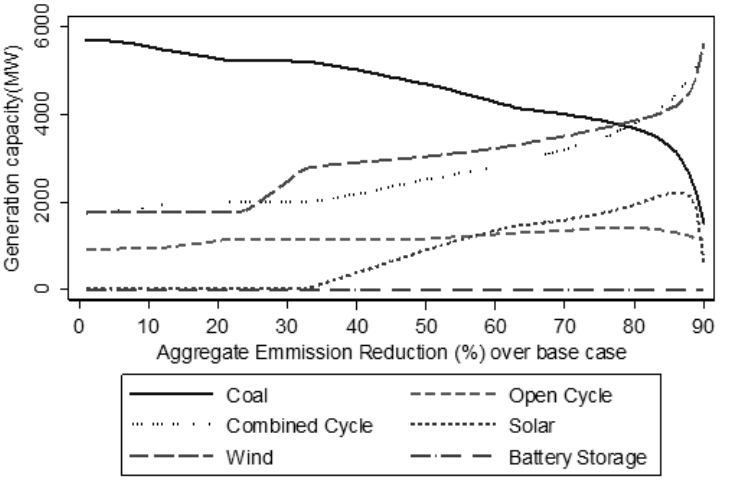
Figure 10. The capacities of fossil fuel power and renewables with increasing carbon emission reduction. With an 85% emissions-reduction target, the total capacity of wind and CCGT is 11,256 MW, which is much higher than peak demand (8854 MW). At the same time, OCGT capacity remains quite high. The results show that, to backstop intermittent renewables when the emission reduction standard is high, overinvestment in CCGT, OCGT, and reinforce the missing money problem. With a 90% emission-reduction target, total